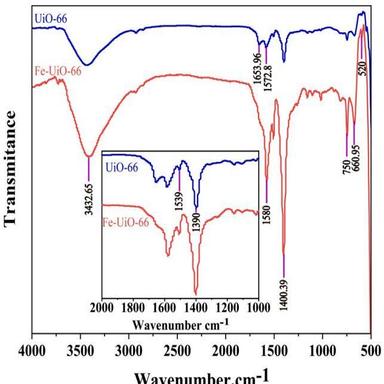
XPS spectra of UiO-66 and Fe-UiO-66: (a) survey scan, (b) Zr 3d, (c) O 1s and (d) Fe 2p XPS in Fe-UiO-66.